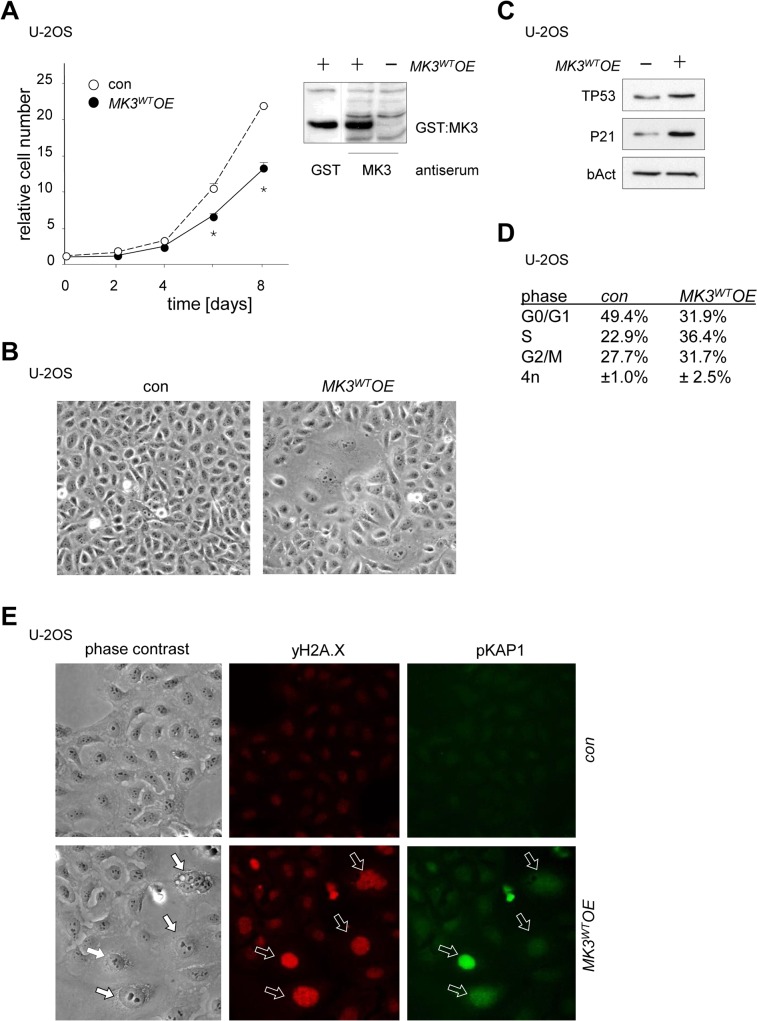
Proliferative regulation by MK3 in cancer cell lines.(A) Proliferation curves (left) of U-2OS cells expressing a retroviral MK3 vector (MK3
WT
OE; filled circles) or an empty vector (con; open circles); overexpression of GST-MK3 (MK3
WT
OE) in U-2OS cells detected with and GST or a MK3-antiserum (right panel). Cell counts at t = 2 through t = 8 were normalized to cell counts at t = 0 for each transduced cell culture individually (see Methods section for details); statistical significance was determined by two-tailed Student’s t-test and is presented relative to the empty vector control (* p < 0.05). (B) Phase contrast images showing cell morphology in U-2OS/MK3
WT
OE cells and control cells. (C) Protein expression levels of the check-point regulator proteins TP53 and p21CIP1/WAF1 (P21) in U-2OS/MK3
WT
OE cells; loading control b-Actin (bAct). (D) DNA profile analysis of U-2OS/MK3OE versus control cells (4–6 days post-transduction; representative experiment). MK3
WToverexpression elicits an intra S-phase arrest: table shows a substantially increased S-phase occupancy. (E) Immunohistochemical staining for phosphorylated H2A.X (γH2A.X) and phosphorylated KAP1pSer824 (pKAP1; arrows) to visualize DNA damage in U-2OS/MK3
WT
OE cultures; control (top panels) or MK3
WT
OE (bottom panels).